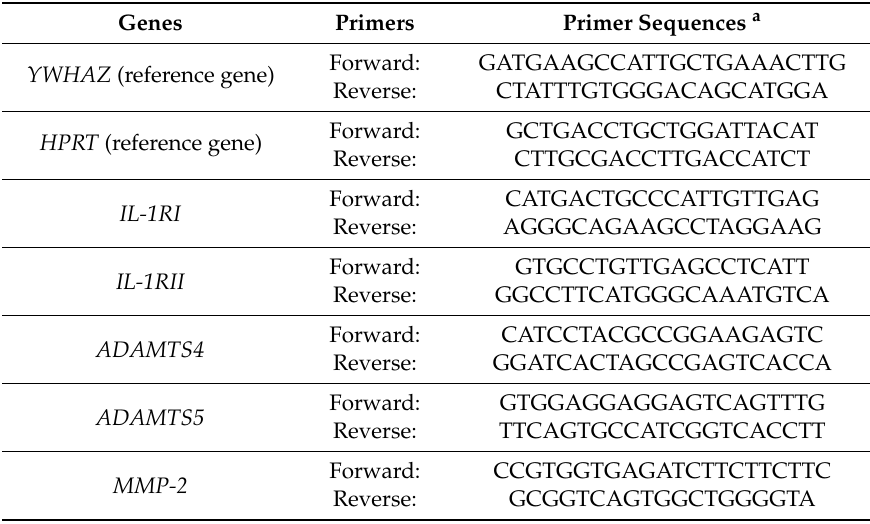
Table 3. Primers used for real-time